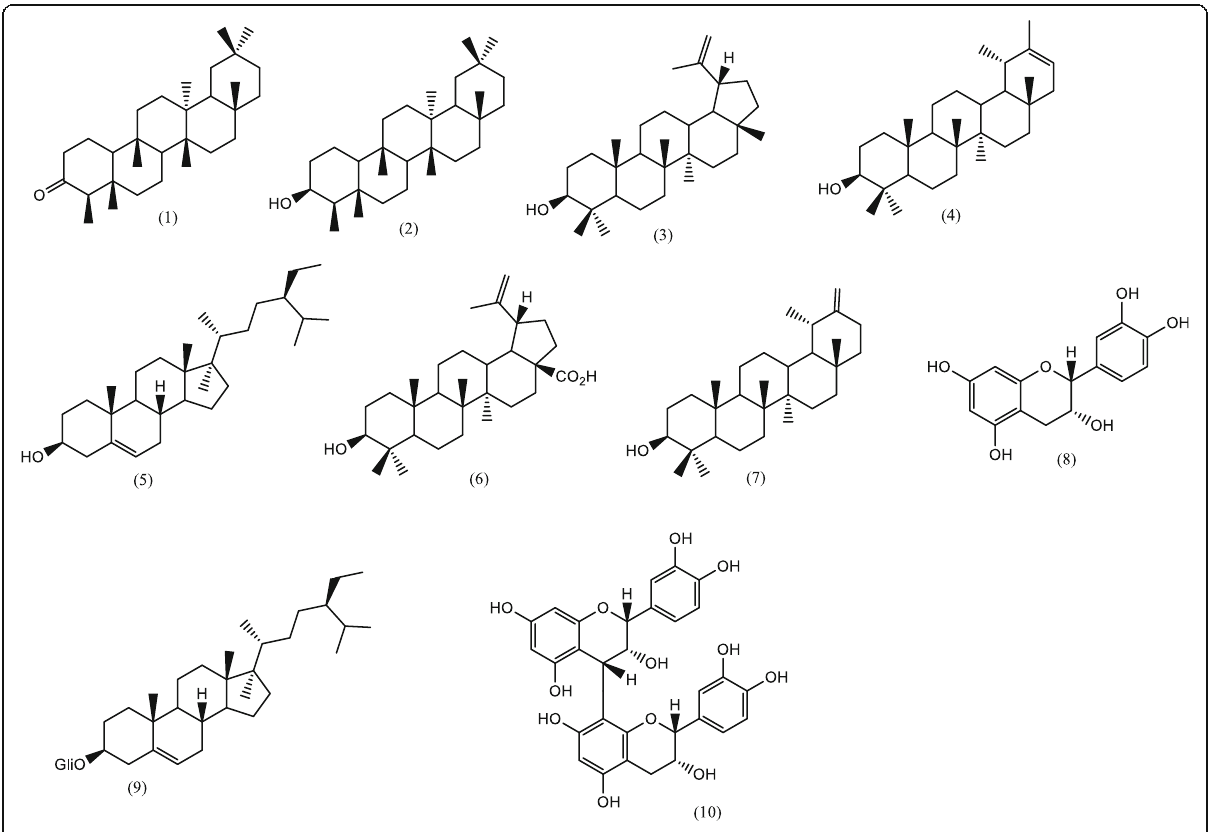
Fig. 1 Chemical structure of the compounds isolated from stem bark of L . ochrophylla Mart: Friedelin ( 1 ), β - friedelinol ( 2 ), lupeol ( 3 ), pseudotaraxasterol ( 4 ), β -sitosterol ( 5 ), betulinic acid ( 6 ), taraxasterol ( 7 ), ( − )-epicatechin ( 8 ), β -sitosterol-3- O - β -D-glucopyranoside ( 9 ), and (+)-epicatechin-(4 β -8)-epicatechin (procyanidin B2) ( 10